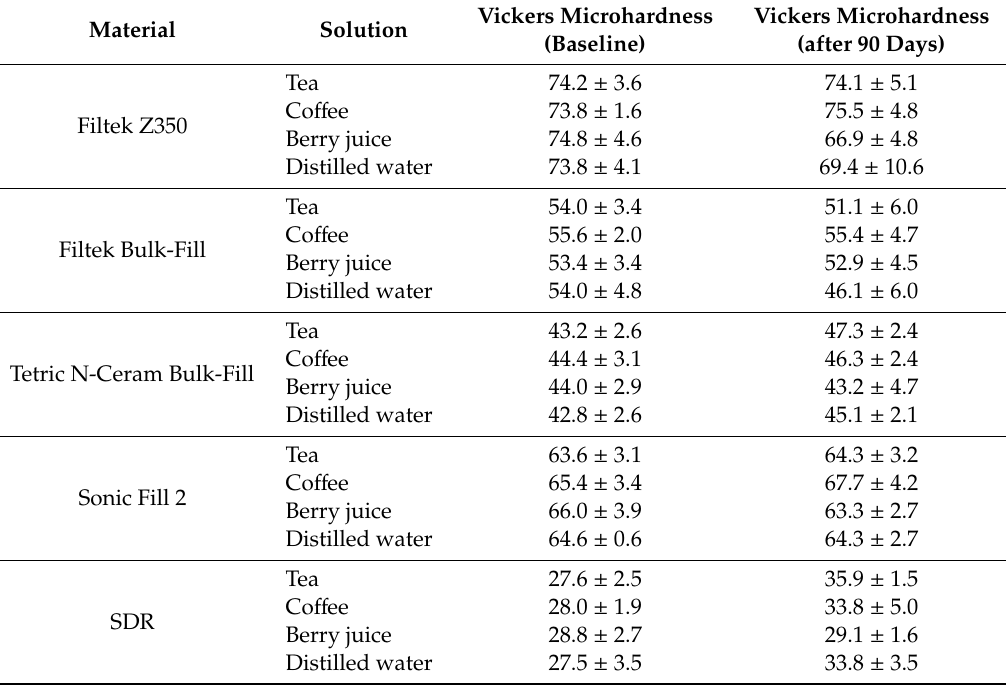
Table 2. Means and standard deviations of Vickers microhardness values of di ff erent materials at baseline and after immersion in di ff erent solutions for 90